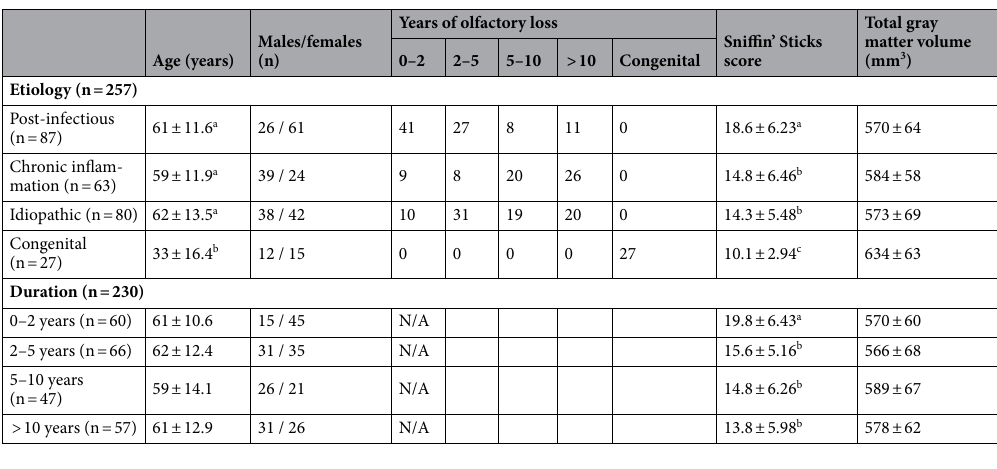
Table 1. Demographics of patients who were included in the analysis, categorized on etiology and duration of olfactory loss. Age, Sniffin’ Sticks scores and gray matter volumes are reported as mean ± SD. Rows for etiology or duration that do not share similar superscript letters (a or b) are significantly different. In case no letters are shown, there were no significant differences for that